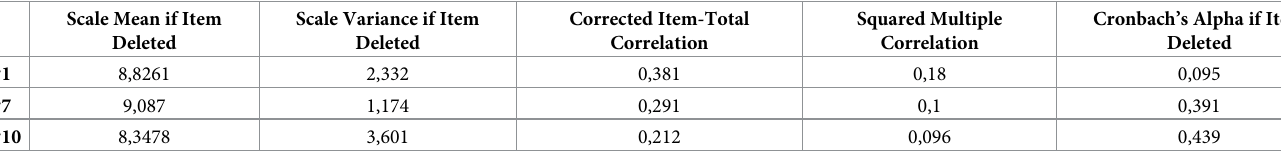
Table 11. Item-total statistics for subscale 1 (IGs).